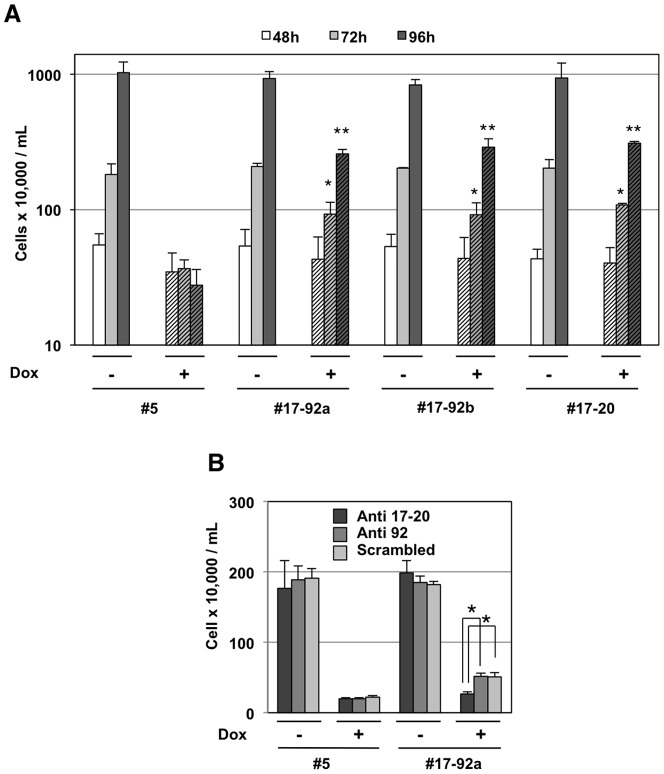
miR-17 and miR-20a are sufficient for partial rescue of Fli-1 knock-down induced cell proliferation arrest.A: Equal numbers of parental NN10#5 cells and of their three derivative clones #17-92a, #17-92b and #17-20 were cultured for 96 h in the presence or absence of Dox as indicated. Histogram shows cell concentrations (log scale) at 48 h, 72 h and 96 h time points, 48 h being the minimum Dox treatment time required for complete Fli-1 knockdown (mean and standard deviations from 3 independent experiments). Asterisks (p<0.05) and double asterisks (p<0.01) show significant differences between NN10#5 cells and derivatives in presence of Dox. B: Equal numbers of NN10#5 or #17-92a cells were transfected with control, anti-miR-92a or a mixture of anti-miR-17 and anti-miR-20a and cultured in the presence or absence of Dox. Cell proliferation was determined 72 h after transfection, the latest time point at which anti-miRs are still efficient. Mean and standard deviations of cell densities (n = 3) are shown (linear scale). Statistically significant differences are indicated by asterisks (p<0.01).